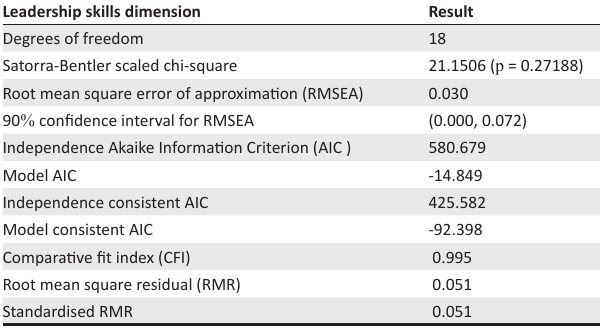
TABLE 4: Goodness of fit statistics for the 1D1E measurement model.